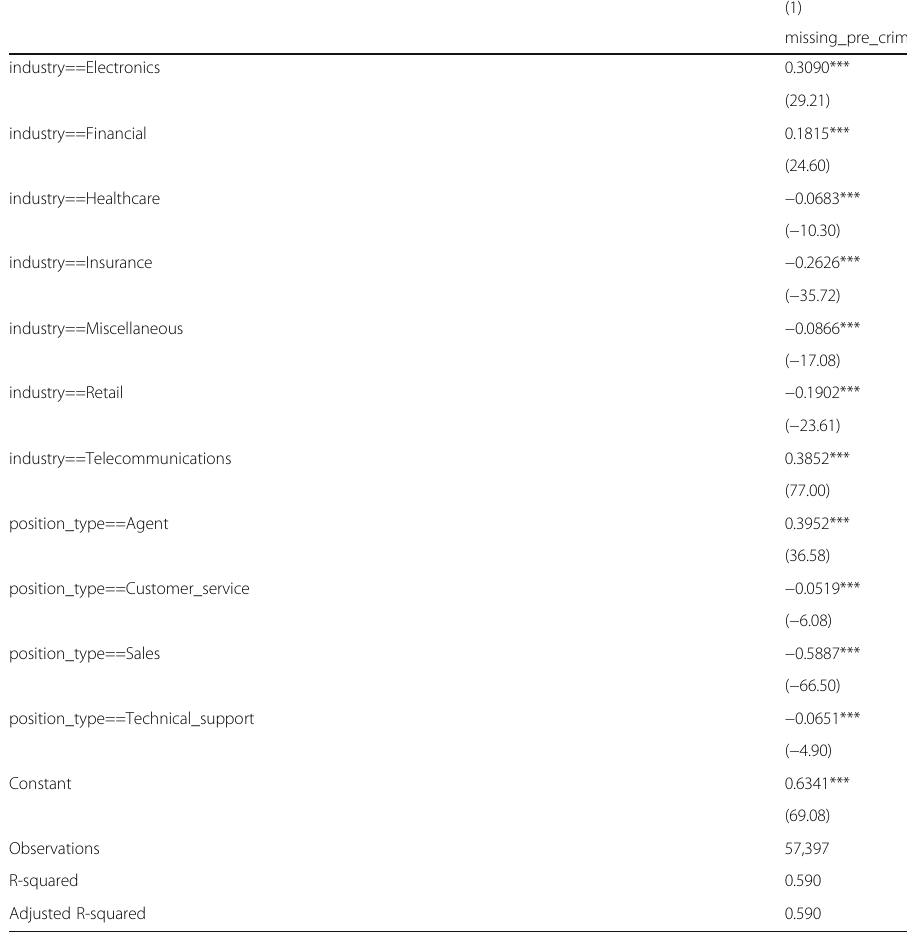
Table 12 Industry correlates of missing criminal